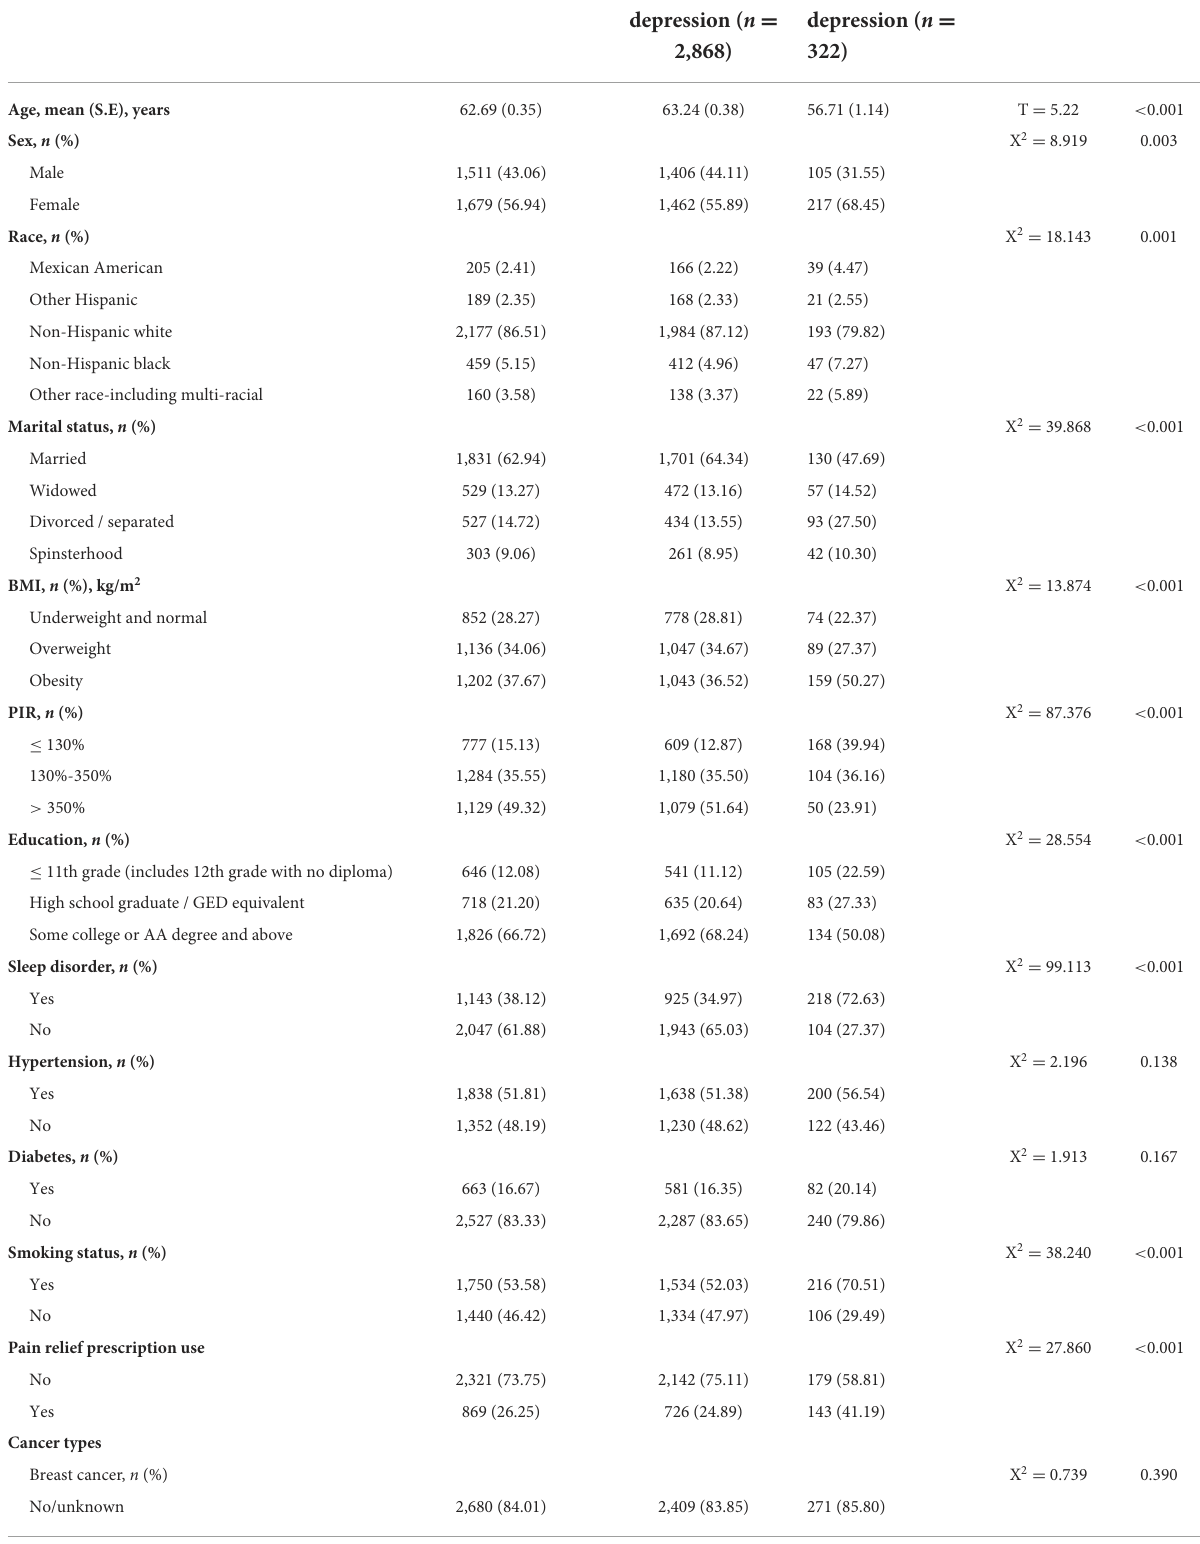
TABLE 1 Characteristics of included